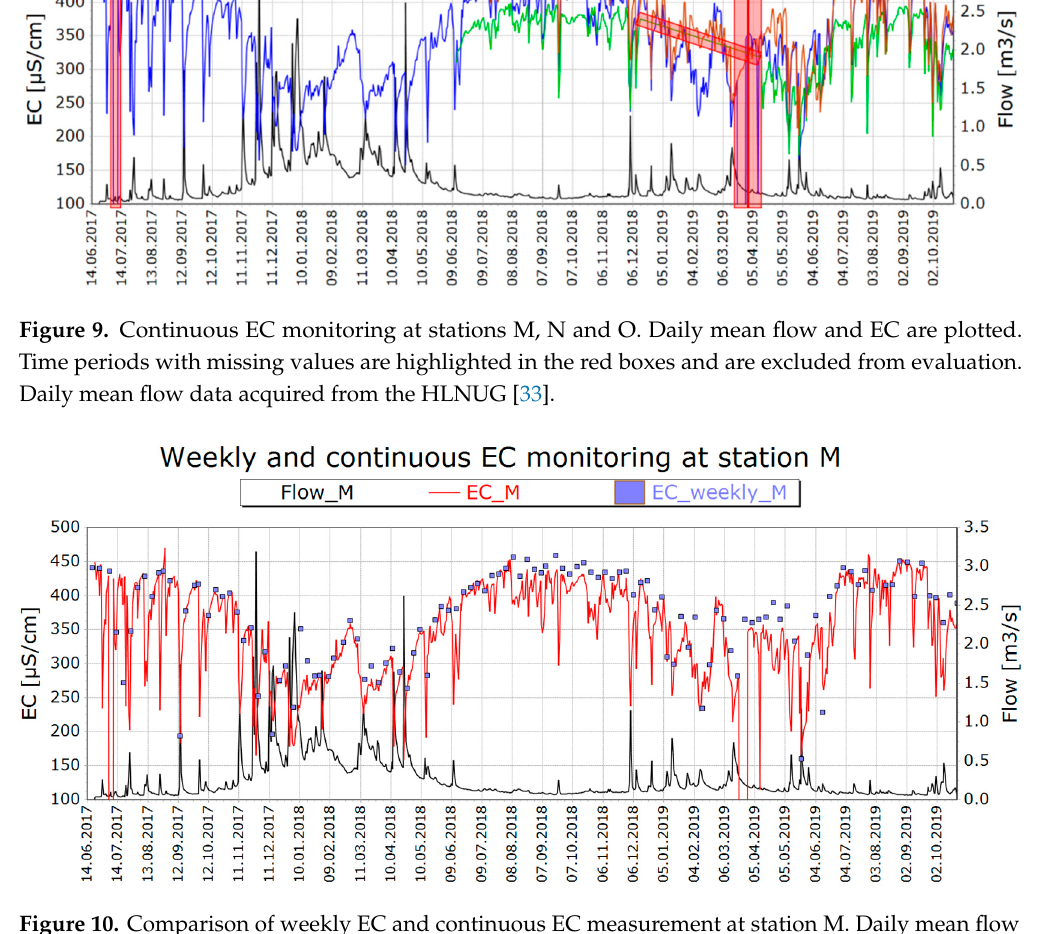
Figure 10. Comparison of weekly EC and continuous EC measurement at station M. Daily mean flow data acquired from the HLNUG [33].